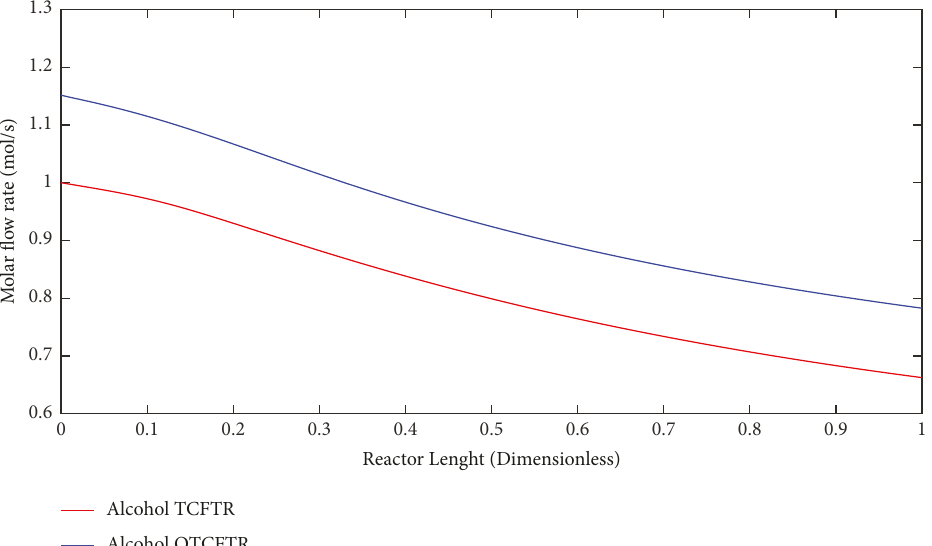
Figure 14: Comparison of the molar flow rate of 2-butyl alcohol in the exothermic part along the reactor length for TCFTR and OTCFTR.